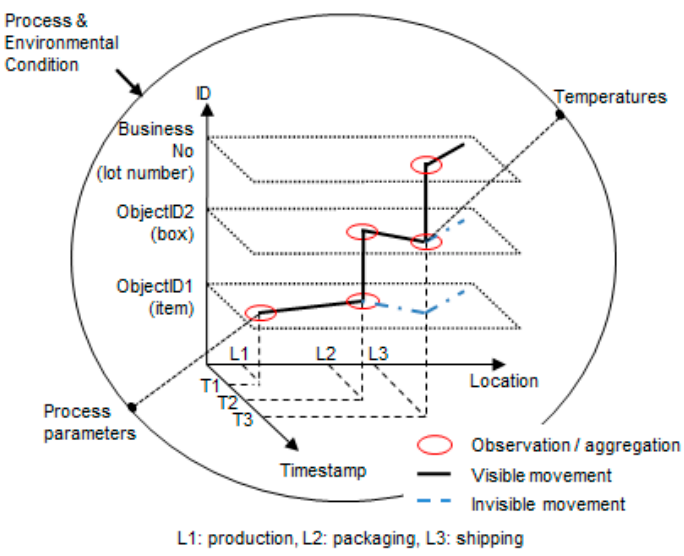
Figure 2. Traceability data (extended from [10]).